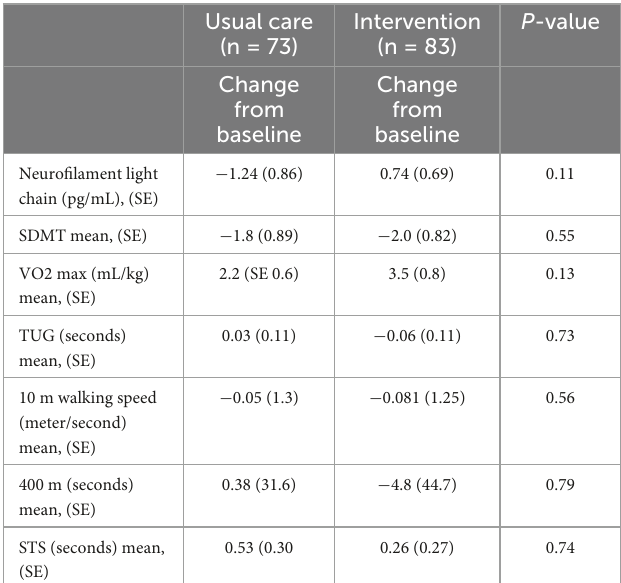
TABLE 2 Effects of the intervention.